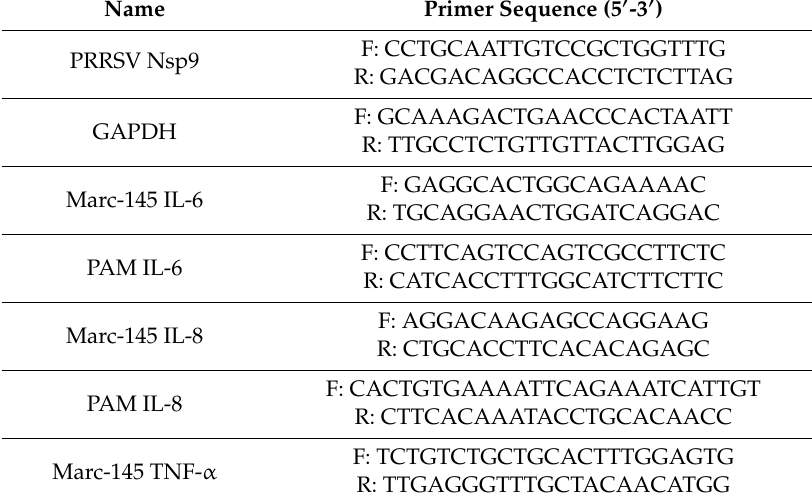
Table 1. Sequences of the primers and probe used for Real-time polymerase chain reaction